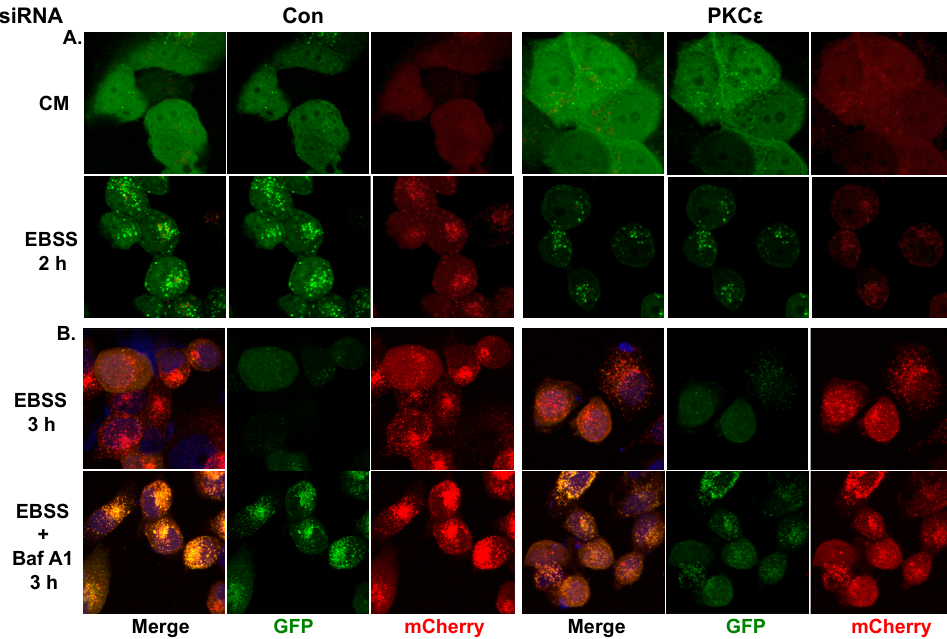
Figure 5. PKC ε knockdown decreased starvation-induced autophagic flux. T47D cells expressing mCherry-GFP-LC3 were transfected with control or PKC ε siRNA and then grown in either complete media or in EBSS for 2 h ( A ). ( B ) Cells were incubated in EBSS for 3 h in the presence or absence of 100 nM Baf A1.